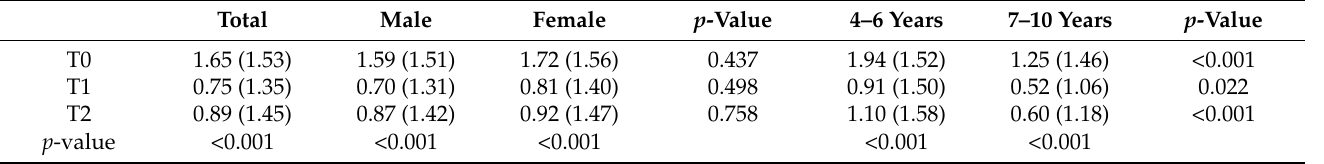
Table 2. Venham score.